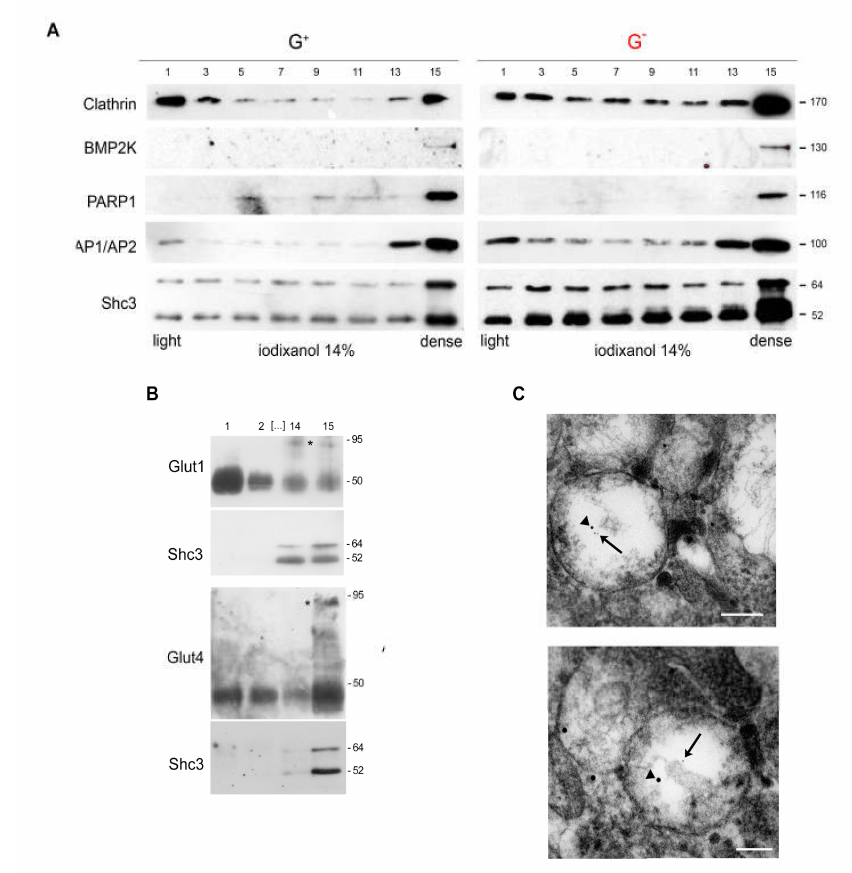
Figure 5. Glycosylated GLUTs co-fractionate with SHC3. ( A ) U-87 MG cells were maintained according to the scheme in Figure 1D, harvested, lysed and the low density microsomes (LDM) fraction separated by ultracentrifugation. The LDM fraction was further fractionated on self-generated iodixanol gradient and the fractions submitted to Western blotting analysis with the antibodies specified in the left column. SHC3, BMPK2, AP1 / AP2 and PARP1 all peak in the densest fraction at a 14% iodixanol gradient. This is true both for cells deprived (G − ) or not deprived (G + ) of glucose. ( B ) Same as in 5A, U-87 MG cells were maintained under normal culture conditions and not deprived of glucose. The densest fractions of the 14% iodixanol gradient are enriched in Sch3 and glycosylated GLUT1 and GLUT4 (*) that are distinguishable from their unglycosylated forms by their higher apparent molecular weight. ( C ) Immunoelectron microscopy of vesicles contained in the LDM fraction. The presence of PARP1 (15 nm gold particles, arrowheads) and SHC3 (5 nm gold particles, arrows) in the same vesicles was revealed through secondary antibodies linked to the appropriate gold particles. Scale Barr: 200